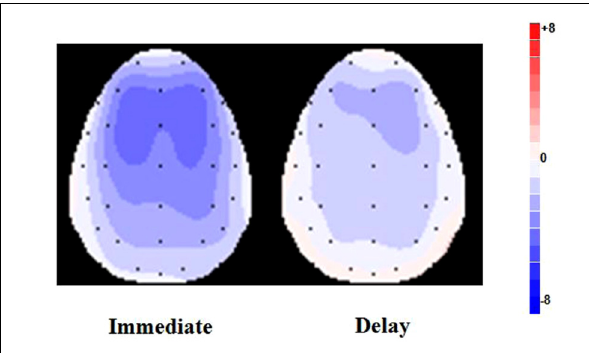
FIGURE 3 | Scalp topographies of the difference waves between ERP responses to the loss vs. gain outcomes averaged for FRN in the time range of 230–330